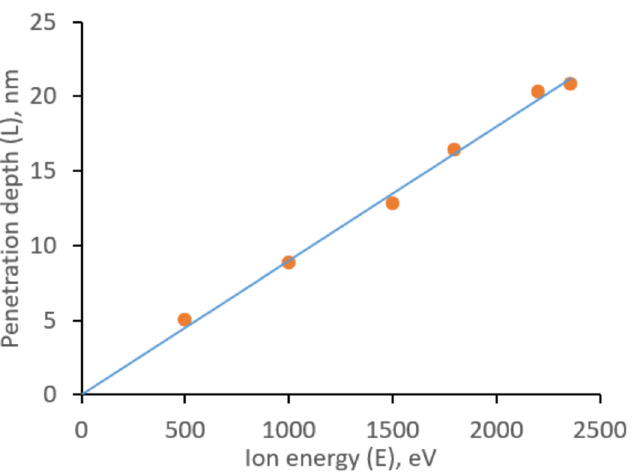
Figure 3. Dependence of the penetration depth of the Ag atom into PCL on its initial